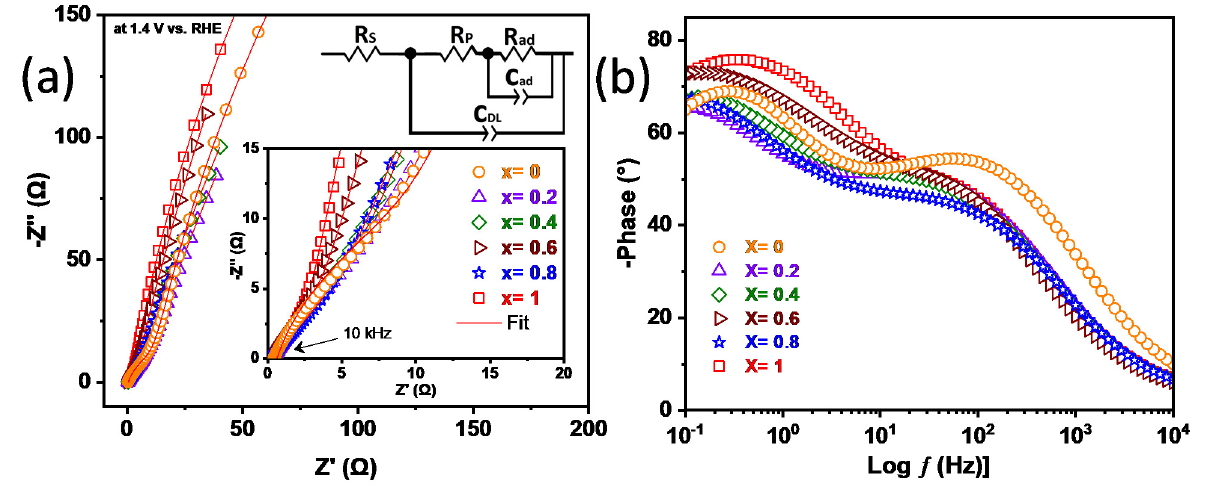
Figure 12. EIS—Nyquist ( a ) and Bode ( b ) plots for the tested electrocatalysts.